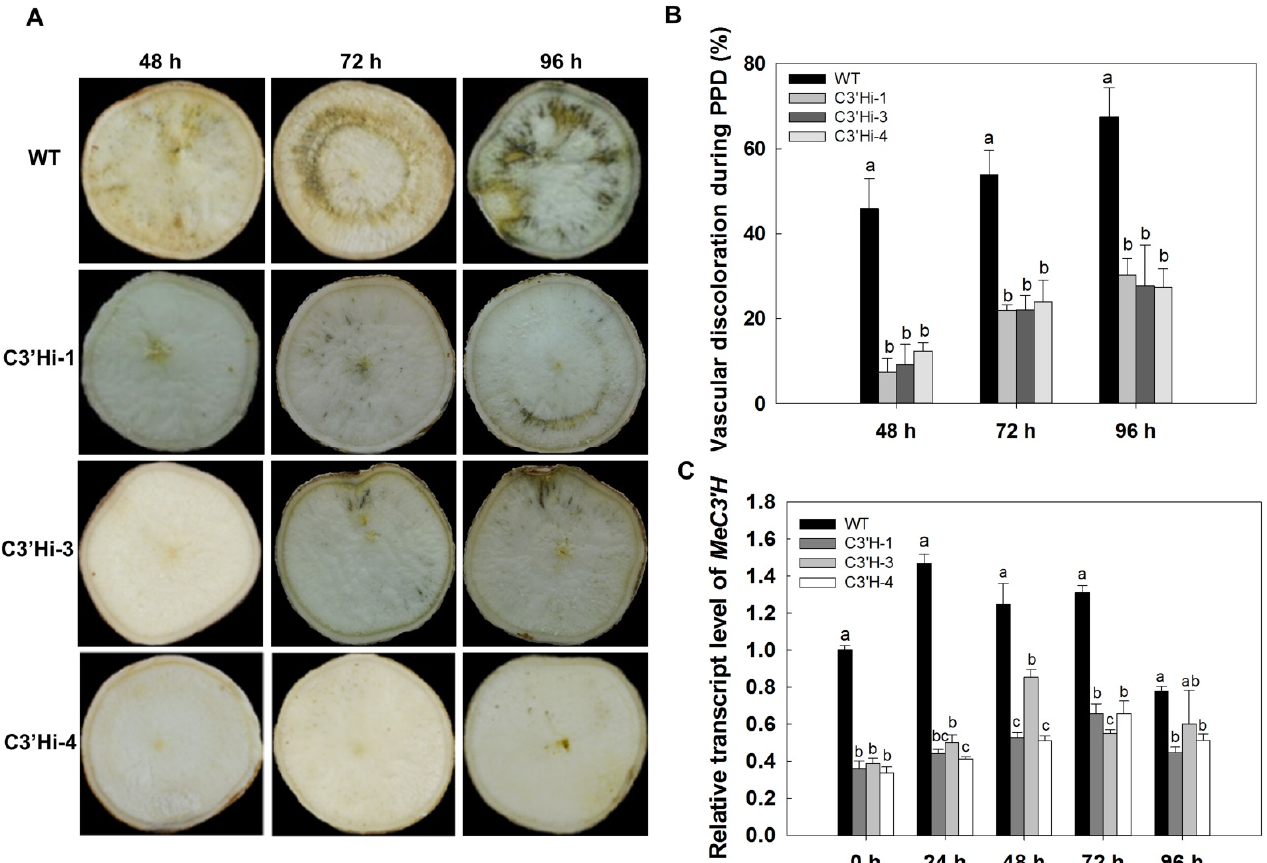
Figure 5. Delayed PPD occurrence in storage roots from transgenic cassava. ( A ) Visual detection of PPD occurrence using the method from the International Center for Tropical Agriculture. ( B ) The levels of vascular discoloration are shown as percentages determined using ImageJ processing software. ( C ) Lower levels of MeC3 ′ H expression in transgenic cassava compared with WT was observed during PPD. Values labeled with different letters (a, b, and c) at different time points are significantly different according to Duncan’s multiple comparison tests at p < 0.05.